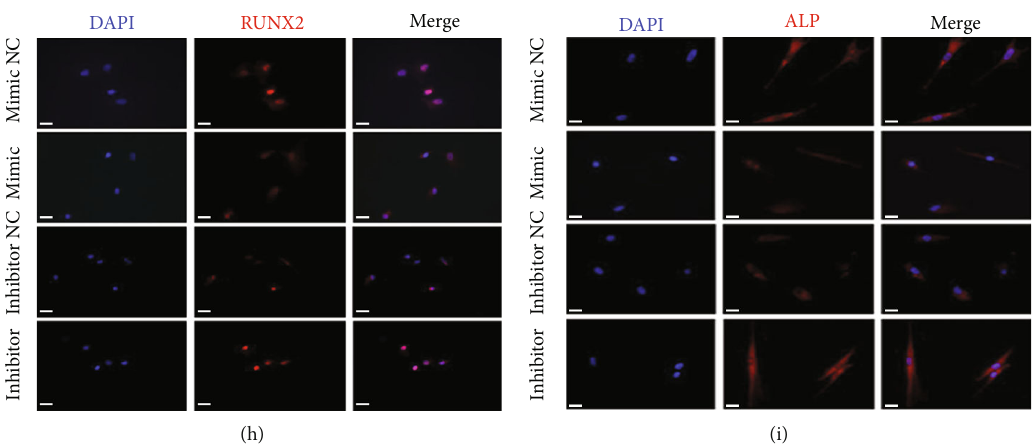
Figure 3: Hsa-let-7b inhibited the osteogenic di ff erentiation of PDLSCs. (a, b) Results of ALP staining and ALP activity assay after 7 days of osteogenesis ( scalebar = 100 μ m ). ∗∗ P < 0 : 01 . (c, d) ARS staining and CPC assay at day 14 after osteogenic induction ( scale bar = 100 μ m ). ∗∗ P < 0 : 01 . (e) The expression of osteogenesis-related proteins (ALP, RUNX2, and OSX) after osteogenic induction 3 days of transfected PDLSCs. GAPDH served as the reference protein. (f) Relative grayscale analyses of (e). ∗∗ P < 0 : 01 . (g) The expression of osteogenesis- related genes ( ALP , RUNX2 , and OSX ) in group mimic NC, mimic, inhibitor NC, and inhibitor at day 3, respectively. ∗∗ P < 0 : 01 . (h, i) The immuno fl uorescence staining of RUNX2 and ALP in transfected PDLSCs and matched controls ( scale bar = 50 μ m ).